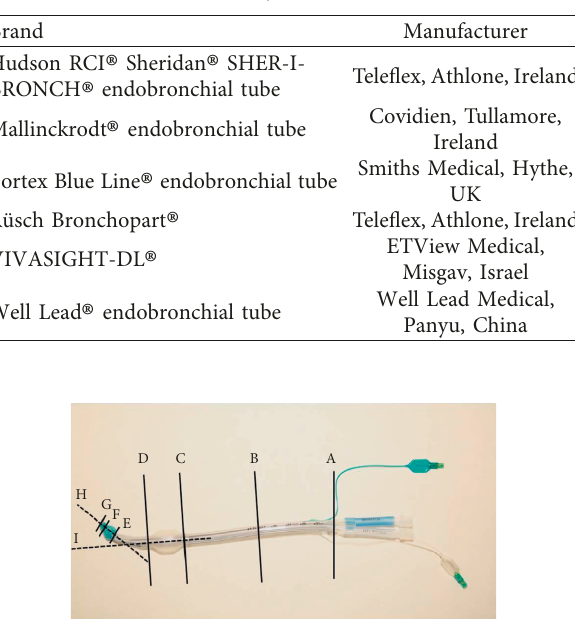
Figure 1: Schematic of localization of measured parameters. A � beginning of the DLT shaft. B � midpoint between the be- ginning of the shaft of the tube (A) and the proximal edge of the tracheal cuff (C). C � proximal edge of the tracheal cuff. D � distal edge of the tracheal cuff. E � proximal edge of the bronchial cuff. F � distal edge of the bronchial cuff. H � virtual extrapolated lon- gitudinal line through the middle of the tracheal tube shaft. I � virtual extrapolated longitudinal line through bronchial tube shaft.